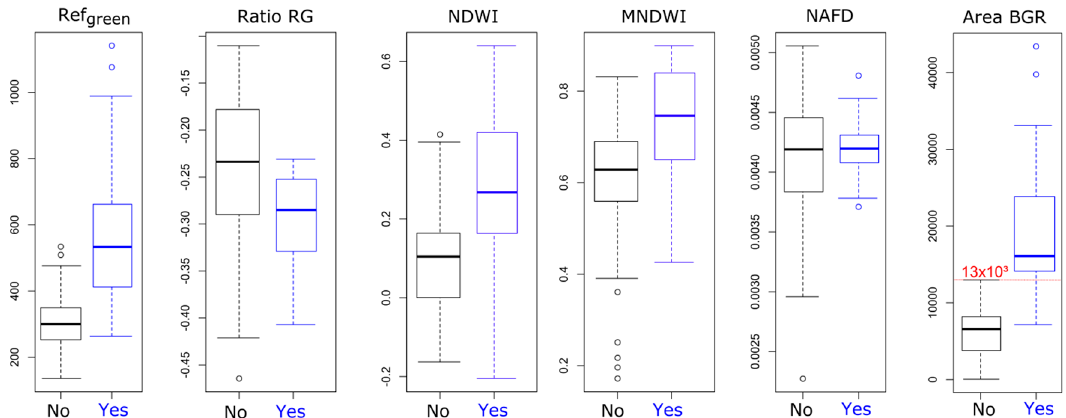
Figure 12. Boxplots of the reflectance of green and the indices of FH of good quality images. The indices are separated into dates with calcite precipitation (“Yes”) and without calcite precipitation (“No”) based on the visual classification of FH. Index “Area BGR” has the best separation of the two classes: the red line marks the conservative threshold 13 × 10 3 as the maximum value of dates without calcite precipitation.